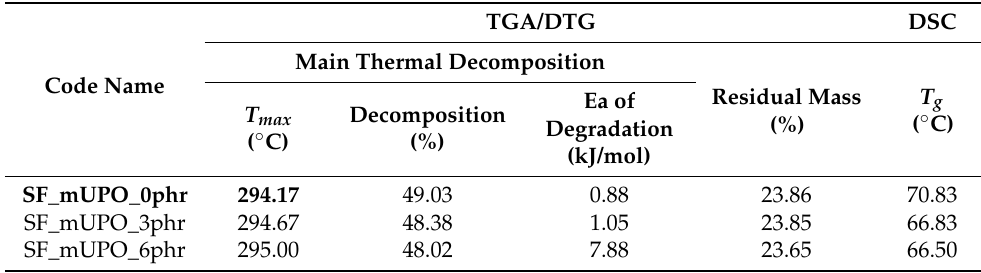
Table 3. The thermal property results of non-glutinous starch foam